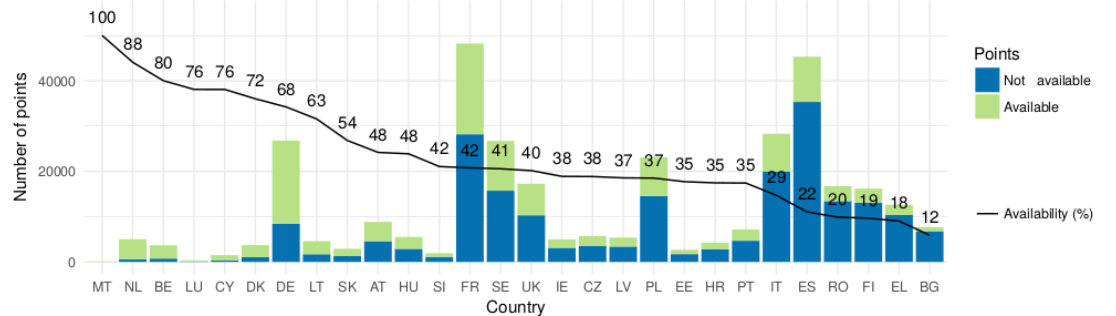
Figure 6. Density by country sorted from the largest availability to the lowest. The bar plot shows the number of LUCAS points for which crowdsourced data are available (green) and not available (blue) summarized by country. The availability (%) is represented by the black line.